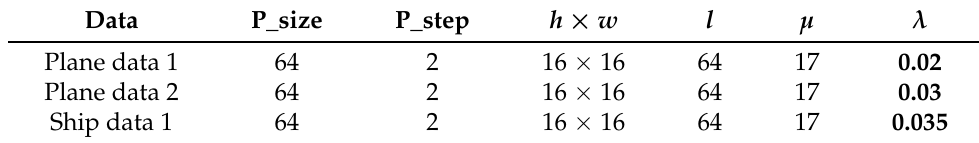
Table 2. The parameter settings of GDL imaging method for different ISAR data sets